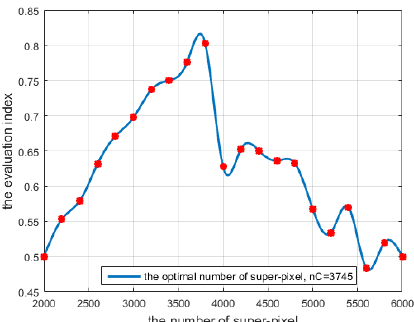
Figure 3. The evaluation index of the optimal super-pixel number